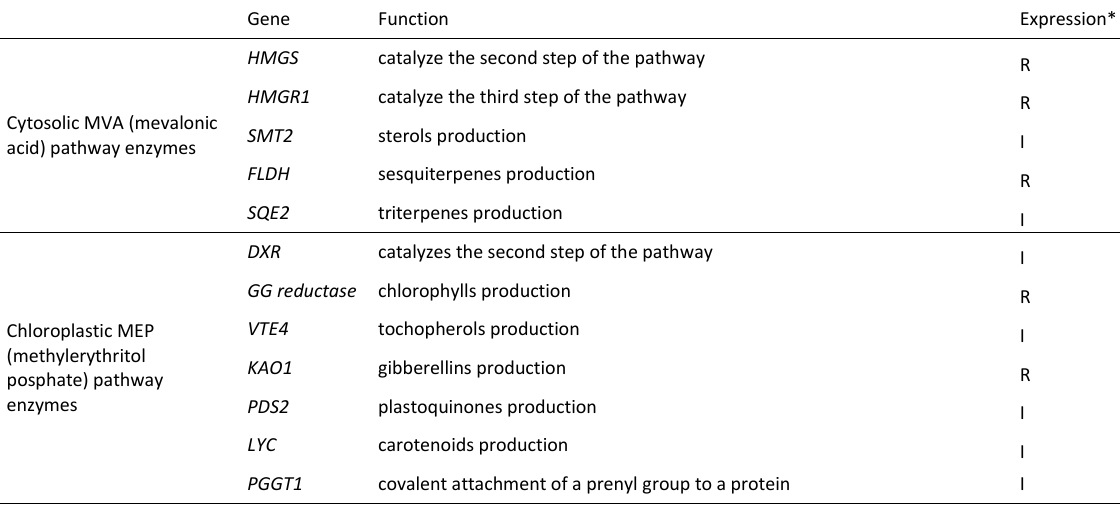
Table 5 : Main DEGs involved in biosynthetic pathways for terpenes and isoprenoids during pear/ V. inaequalis nonhost interaction Gene